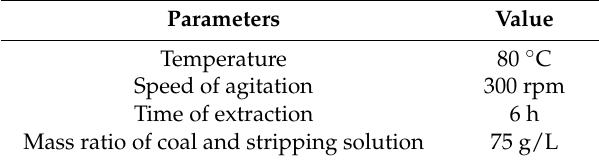
Table 7. Best process parameters of gold desorption from the activated carbon.